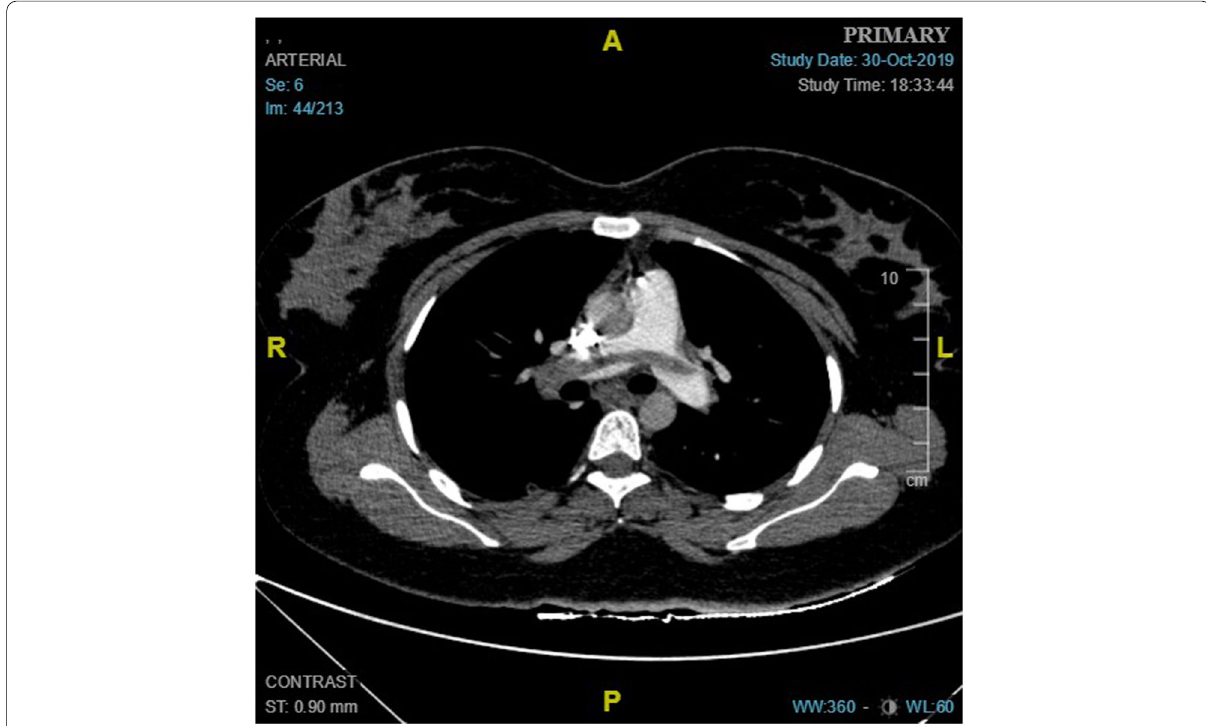
Fig. 2 Computed tomography pulmonary angiography (CTPA) was done which revealed the presence of thrombus in distal main